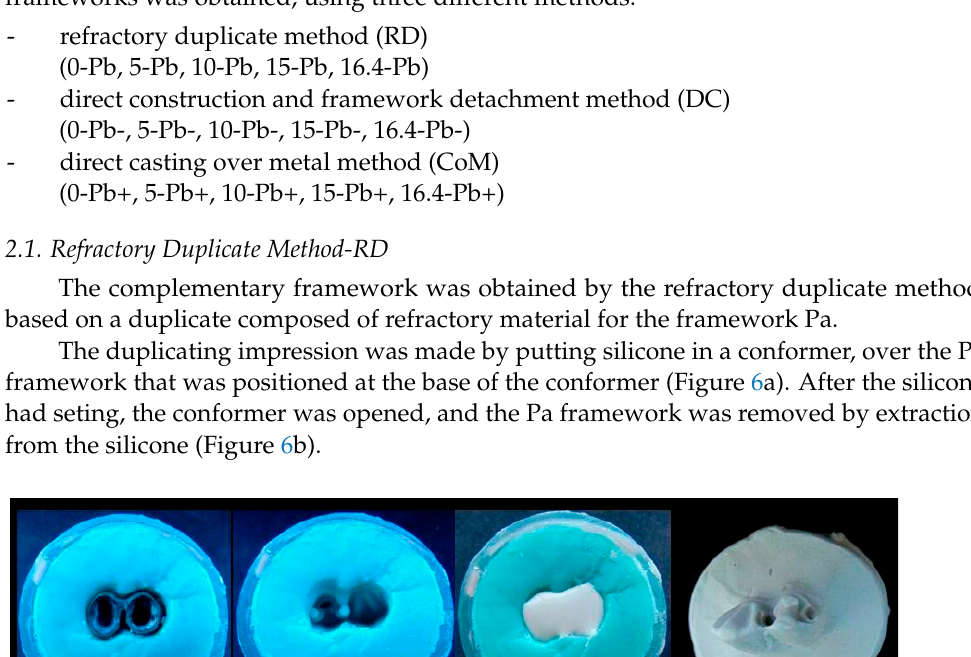
Figure 5. Diagram of the transition from framework P (individual framework) to the series production of Pa frameworks by using the Ma framework wax model.